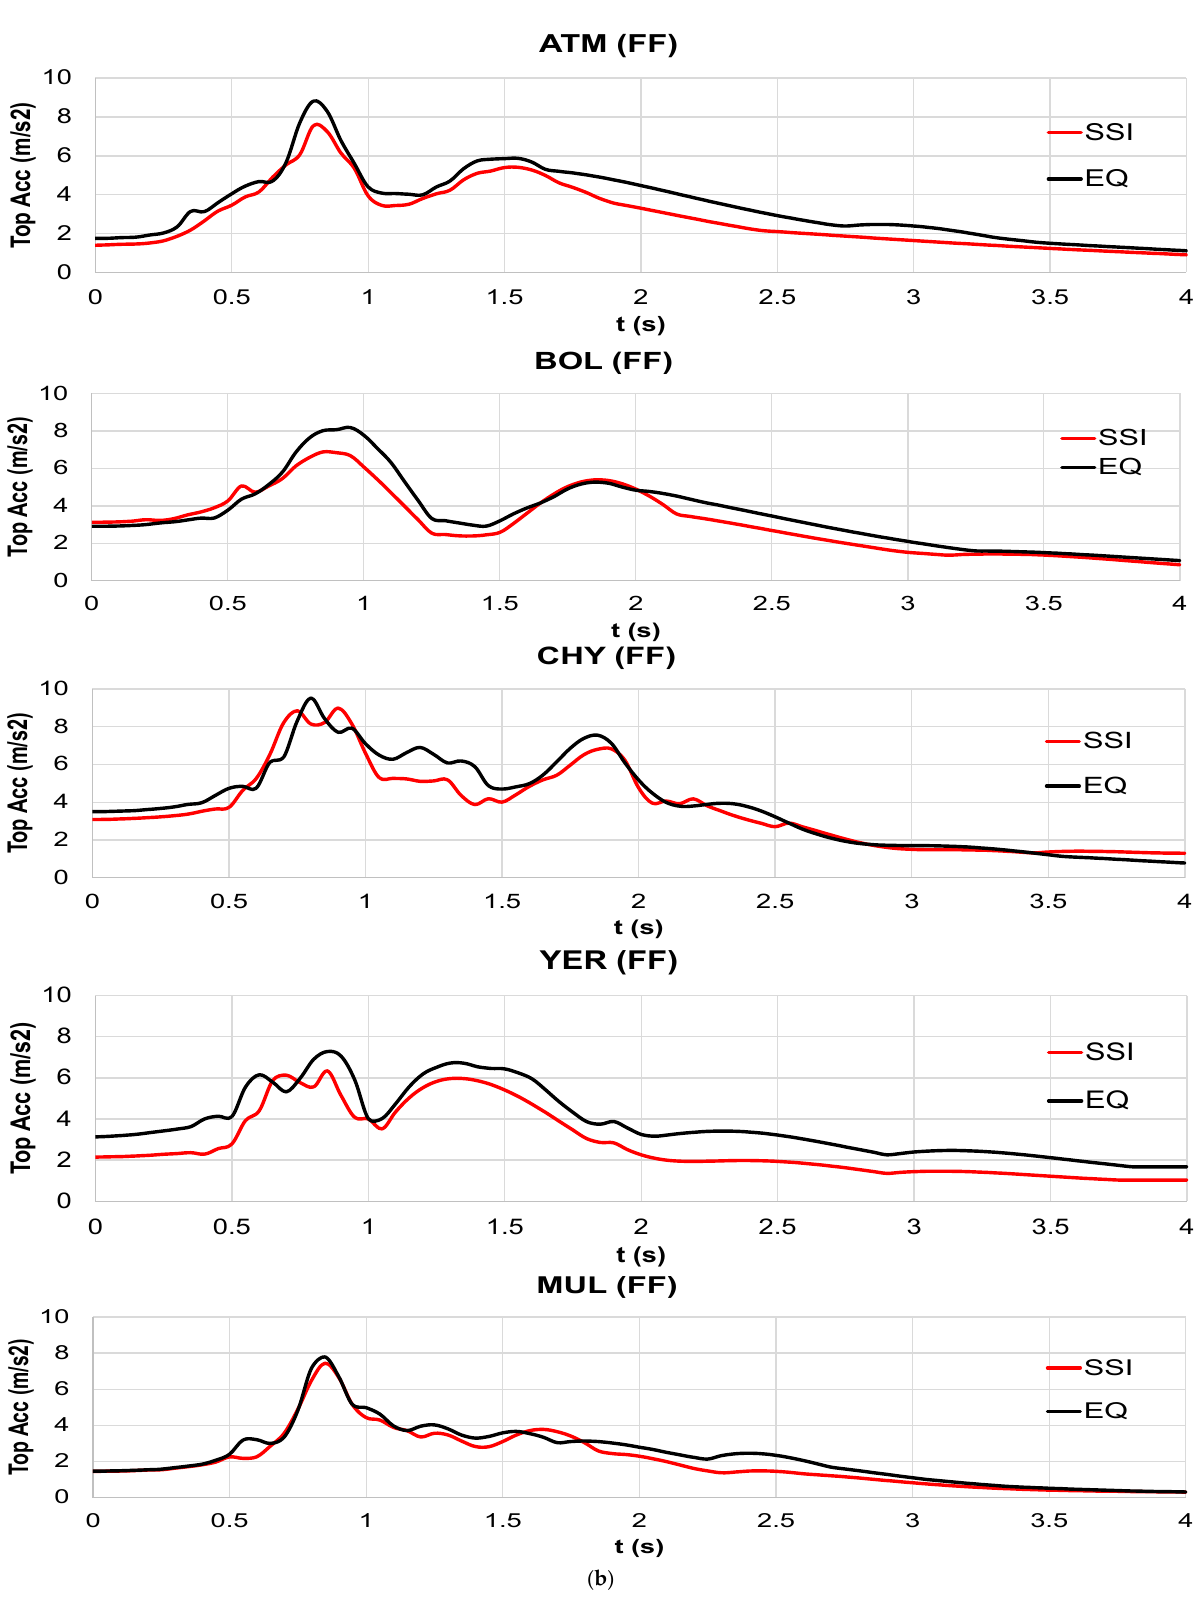
Figure 11. ( a ) Results (near-field (NF) motions): comparison between top spectra: SSI model and EQ model. ( b ) Results (far-field (FF) motions): comparison between top spectra: SSI model and EQ model.